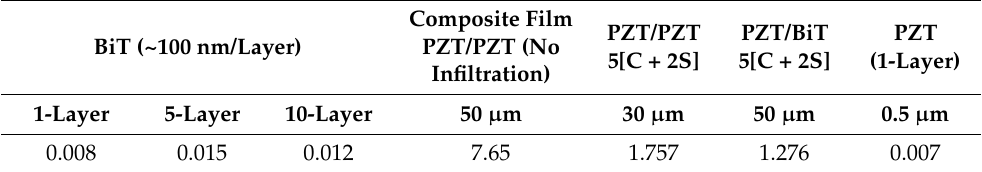
Table 3. Mean values of the average roughness ( Ra ) for the piezoelectric thick films ( µ m).